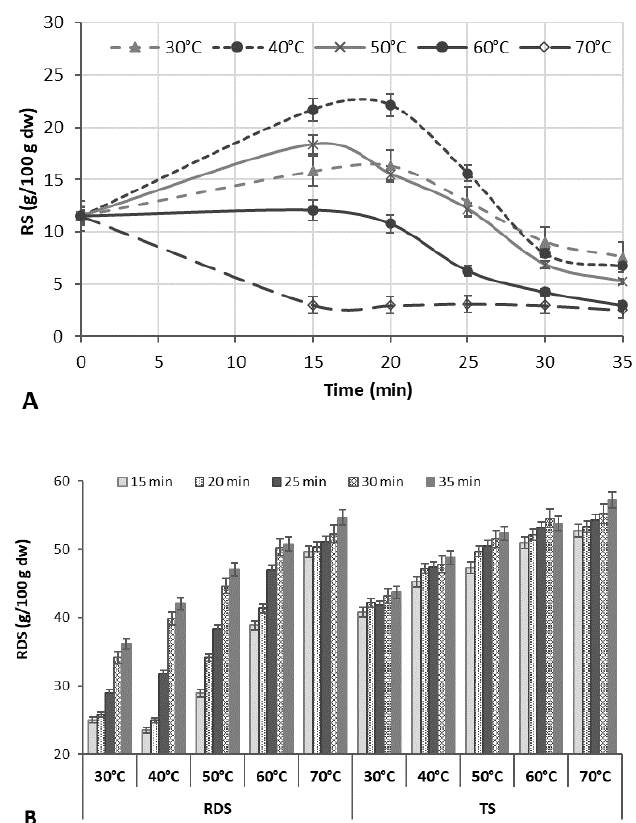
Figure 1. The effect of rice bran ( m/w ratio 1:3) ultrasound treatment at different temperatures and times on resistant starch (RS) ( A ), rapid digestible starch (RDS), and total starch (TS) ( B ) contents.